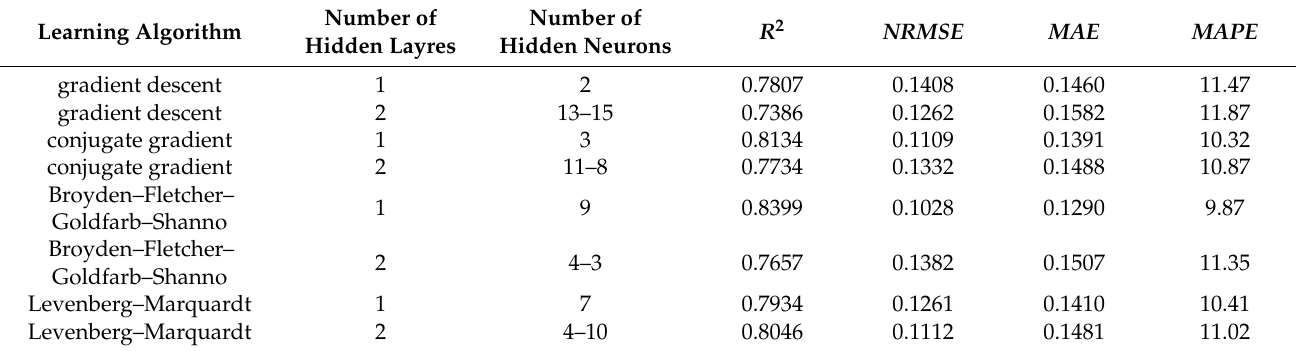
Figure 19. Comparison of models for predicting the pull-off strength of the surface layer f h due to the value of average relative error. Table 4. Comparison of accuracy of compared neural